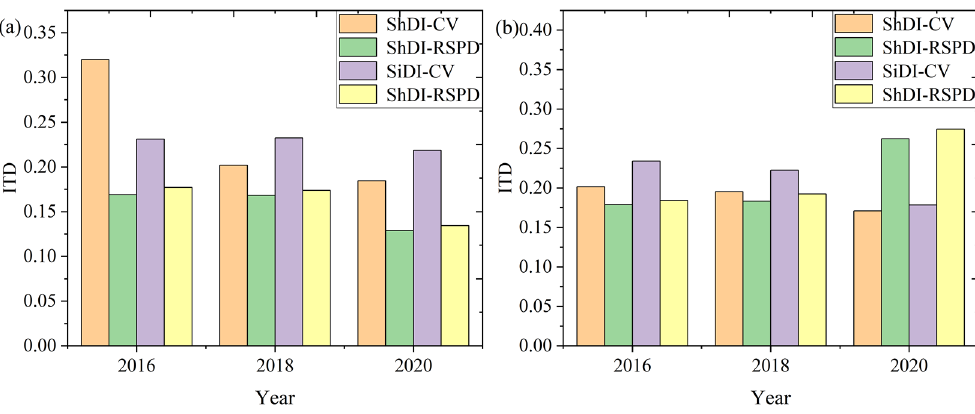
Figure 16. ITD of ShDI/SiDI obtained by the ISODATA method with RSPD/CV. (( a ) is the ITD result of Case I; ( b ) is the ITD result of Case II).